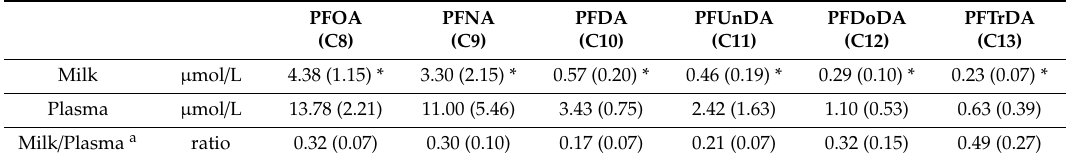
Table 2. Perfluoroalkyl carboxylic acids (PFCA) concentrations in milk and plasma in lactating mice, 24 h after a single IV administration (3.13 µ mol /